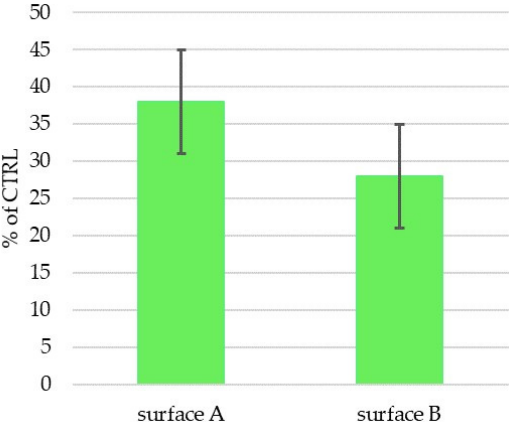
Figure 8. Metabolic activity/cell number of hMSCs cultivated for 72 h on Ti-graphite samples with Surface A and Surface B (activity/cm 2 related in percentage to cell activity on control sample (CTRL- PS)). No statistically significant difference between Surface A and Surface B was observed at the significance level of 0.05.